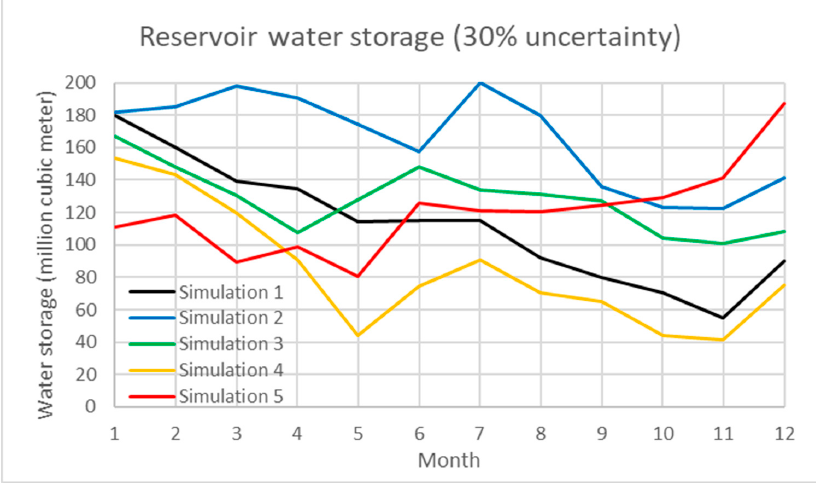
Figure 6. Simulation of water storage in the Shihmen Reservoir under 30% uncertainty of water inflow.